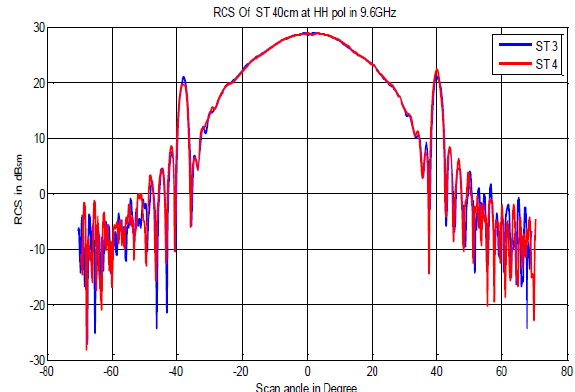
Figure 4(b): Plot of measured RCS values of ST_40cm_3,